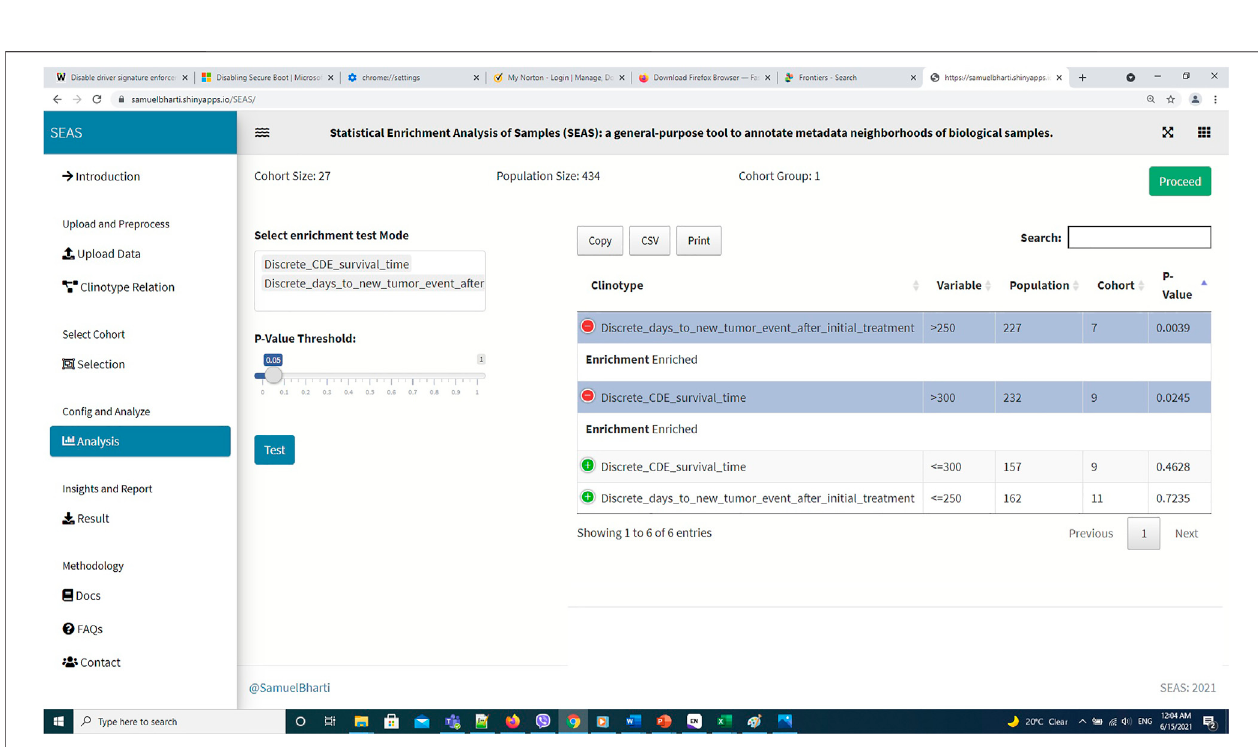
FIGURE 7 | SEAS identi fi es enriched clinical features for the subcohort in Figure 6 .